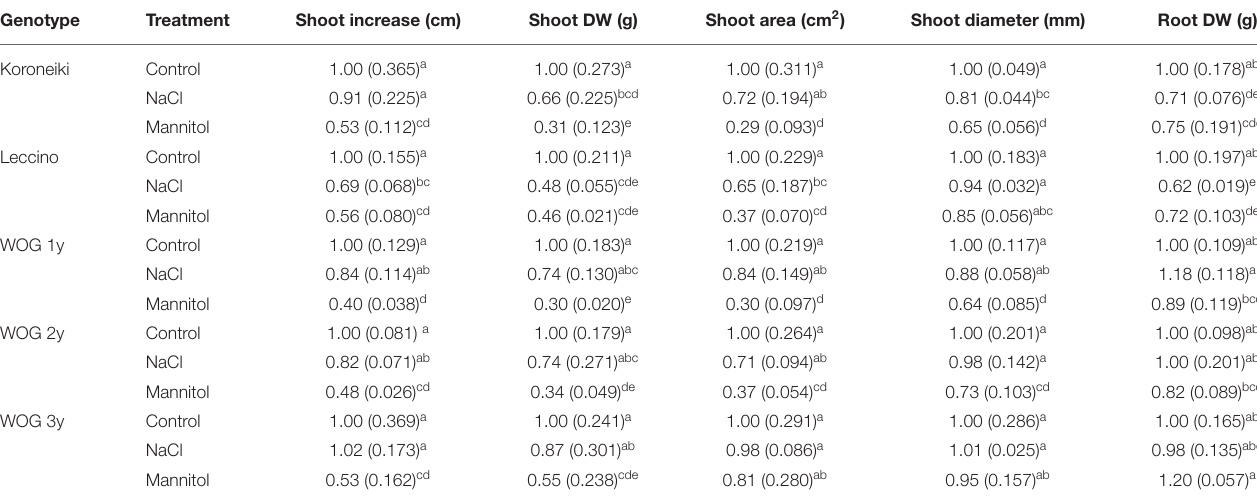
TABLE 2 | The relative growth parameters measured in olives.